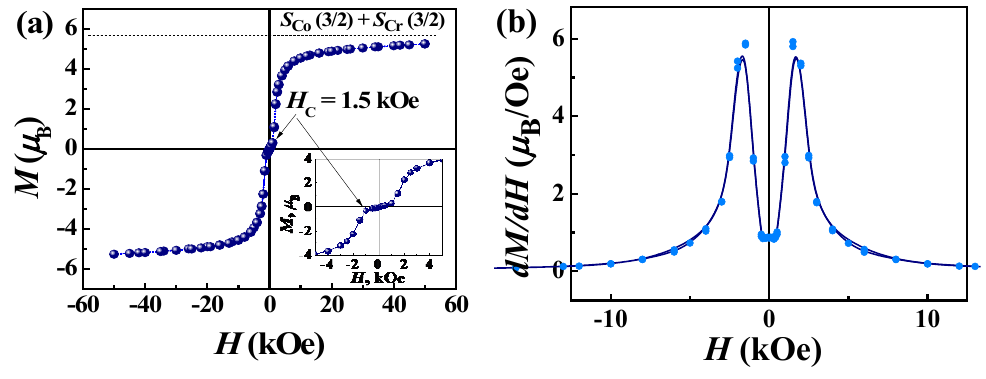
Figure 9. M(H) loop ( a ) and its first derivative ( b ) at 2 K for complex 2 . Unlike 1 and 2 , the trinuclear complexes 3 and 4 are not isostructural. Their magnetic properties differ markedly and, in some respects, are close to those of the corresponding chain complexes. The temperature dependencies of the magnetic susceptibility ( χ M ) and effective magnetic moment ( µ eff ) for the Mn 2 Cr trimer 3 are depicted in Figure 8c. The µ eff value at 300 K is close to the expected value (9.2 µ B ) for two non-interacting Mn(II) and one Cr(III) ions. Upon cooling from room temperature, the µ eff value decreases to approximately 16 K, as in the case of complex 1 , indicating antiferromagnetic interaction between the metallic centers, as was observed in the similar trimer [68]. On further cooling, the µ eff increases to 1.8 K. Unlike 1 , this increase is not accompanied by a subsequent decrease in µ eff associated with AF interactions between the chains in structure 1 . Theoretical analysis of the antiferromagnetic interactions between the Mn II (H 2 dapsc) units belonging to the neighboring chains, which contact through π - π stacking of planar H 2 dapsc ligands and a system of hydrogen bonds in the complex {[Mn(H 2 dapsc)][Fe(CN) 6 ][K(H 2 O) 3.5 ]} n · 1.5 n H 2 O, showed that contacts through π - π stacking play a decisive role in these superexchange AF interactions [52]. In the structure 1 , along the a -axis, there are infinite chains of ...-Mn1- Mn2-Mn1-Mn2-... through π - π stacking of the H 2 dapsc ligands with distances between metals of 8.2341(6) and 8.2357(6) Å (Figure 3), whereas in 3, such contacts are present only in pairs (Figure 5). Probably for this reason, interchain AF interactions in 3 are very weak compared to those in 1